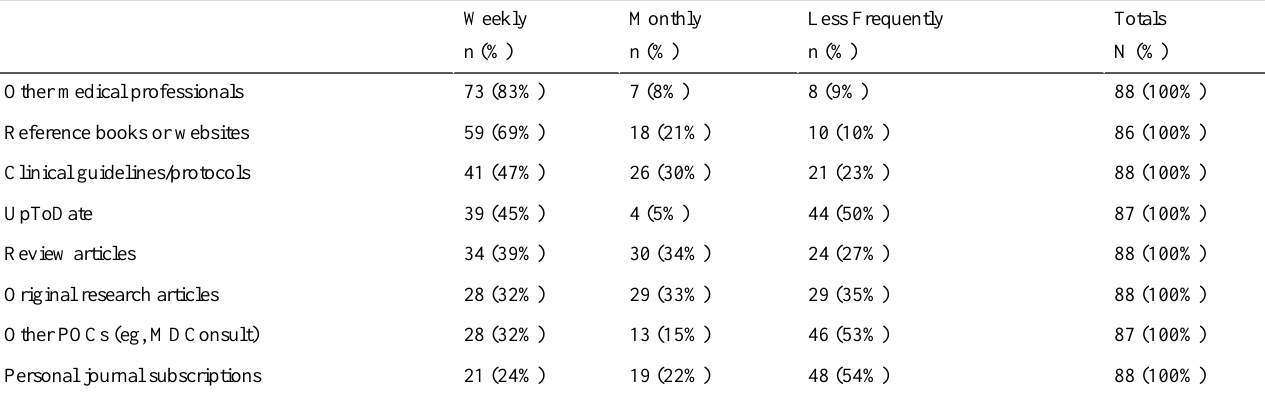
Table 2. Source and frequency of